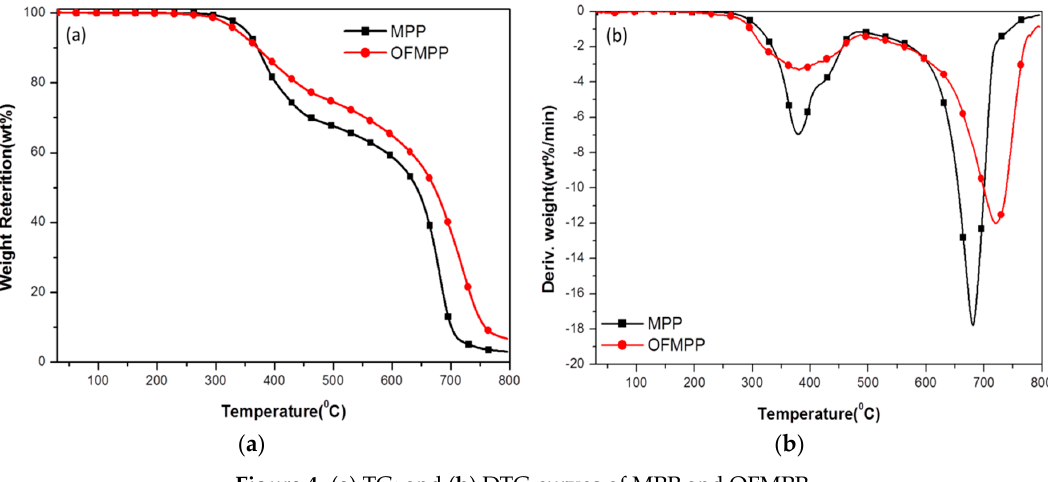
Figure 4. ( a ) TG; and ( b ) DTG curves of MPP and OFMPP.